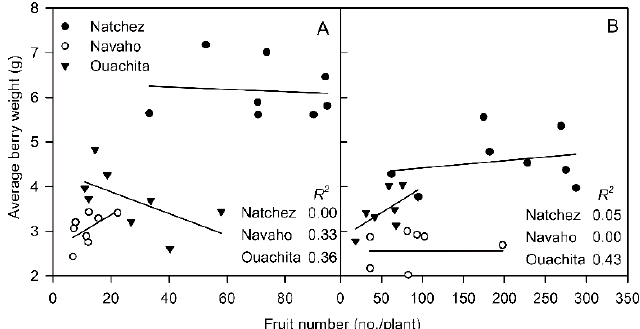
Figure 1. Linear correlation between fruit number and average berry weight of ‘Natchez’, ‘Navaho’, and ‘Ouachita’ blackberry grown under subtropical climatic conditions in the 2015–2016 season ( A ) and the 2016–2017 season ( B ). Plants were treated with gibberellic acid (GA 3 ) at 0 or 49 g·ha − 1 (53 mg·L − 1 ) via spray application with a spray volume of 935 L·ha − 1 on 24 December 2015 in the 2015–2016